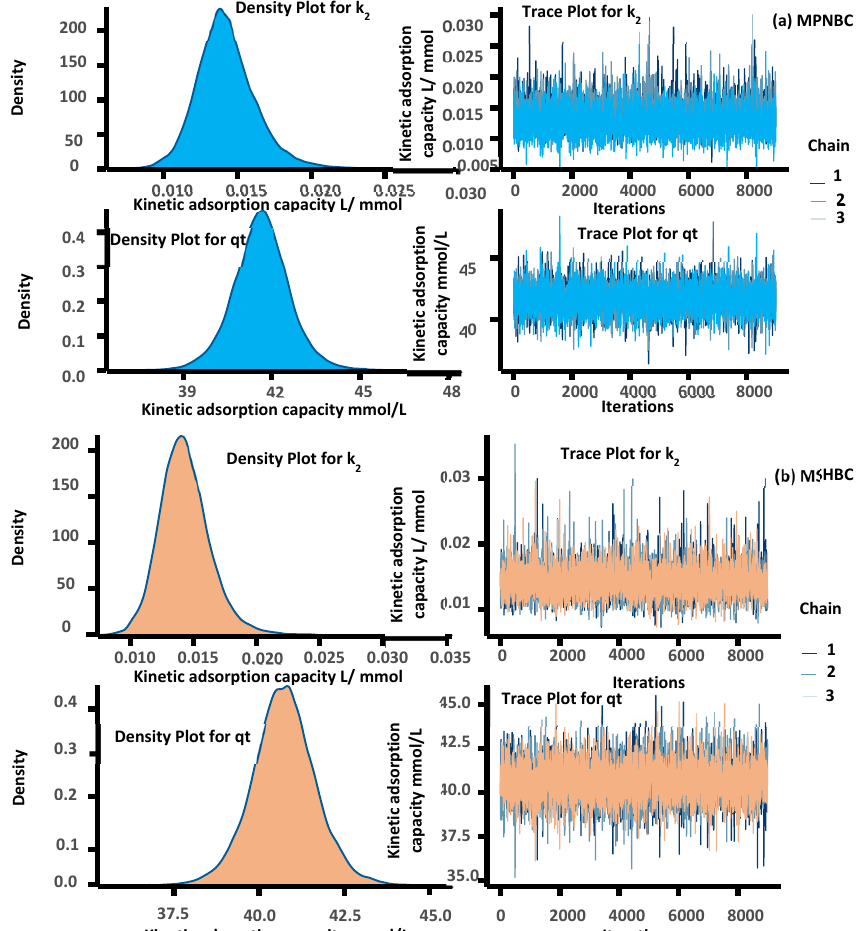
Fig. 3: Density and trace plot parameter presentations of Pseudo second-order model from the Markov chain Monte Carlo chain simulations for the effective use of Bayesian statistics